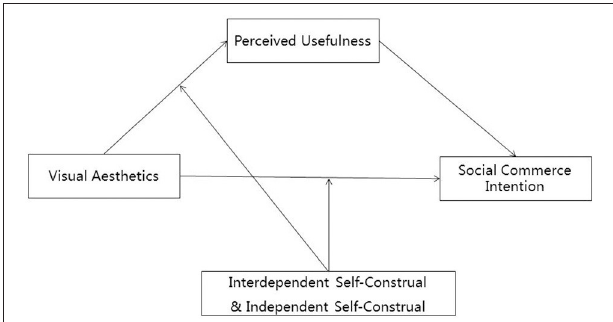
FIGURE 1 | Visual information adoption unimodel (VIAUM) in the context of social